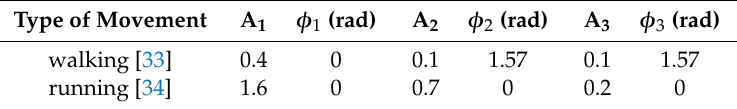
Table 4. Coe ffi cients of Fourier decomposition [28,30,33,34]. Type of